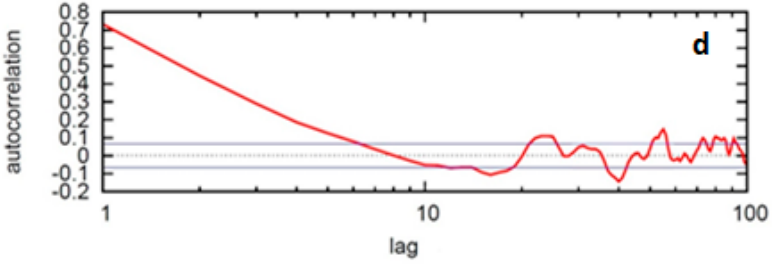
Figure 6. Same as in Figures 2 and 4, except using the National Centers for Environmental Prediction/National Center for Atmospheric Research (NCEP/NCAR) re-analyses for the period 1981– 2010. The top, middle, and bottom diagrams are the Fourier, Wavelet, and autocorrelation diagrams,